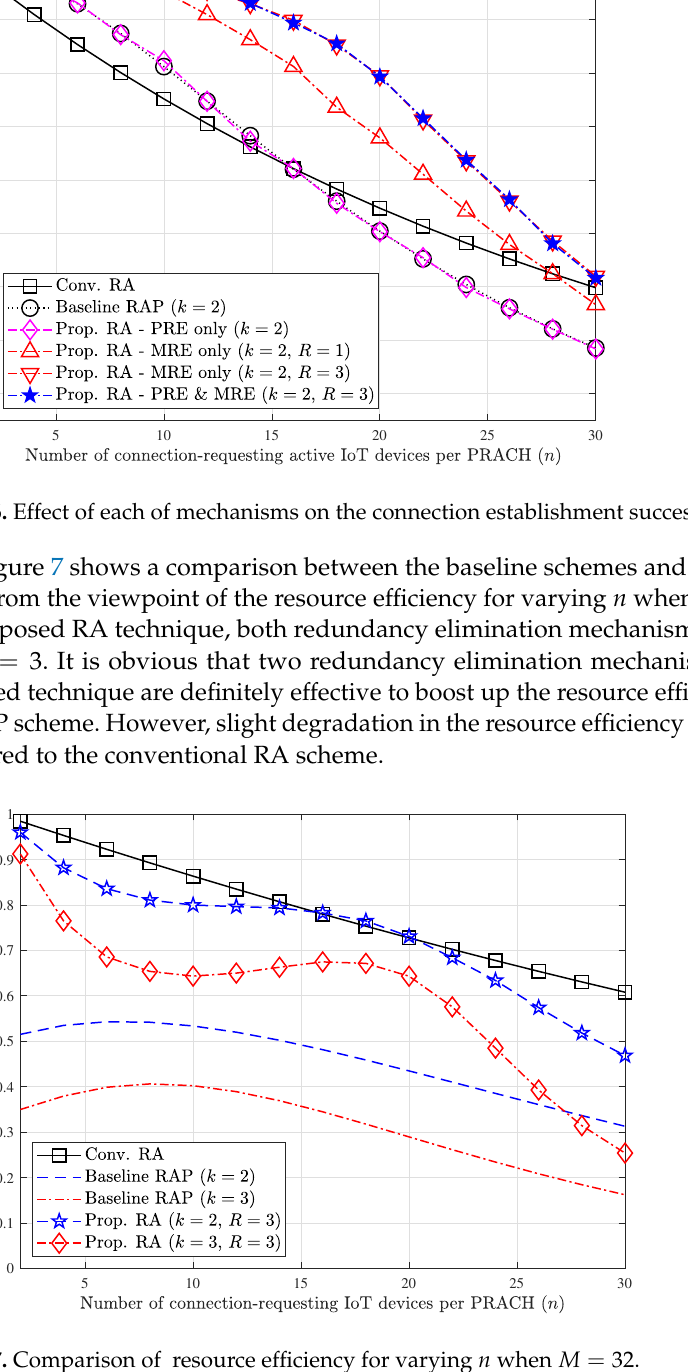
Figure 7. Comparison of resource efficiency for varying n when M =